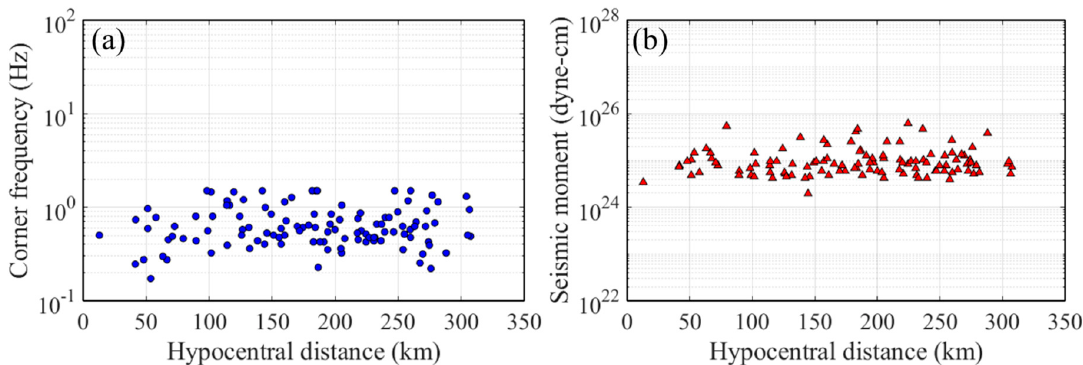
f and M , according to hypocentral distance: (a) Figure 8. Distributions of the values of Figure 8. Distributions of the values of f c and M 0 , according to hypocentral distance: ( a ) Measured c 0 Measured corner frequencies at 111 stations, (b) Measured seismic moments at 111 stations. corner frequencies at 111 stations, ( b ) Measured seismic moments at 111